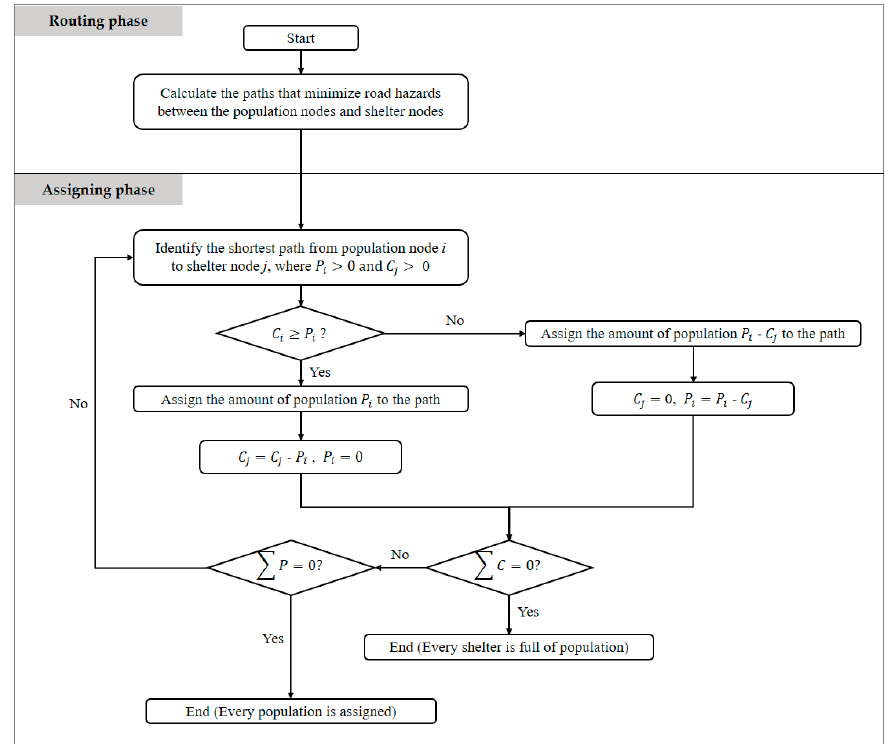
Figure 4. Process of comprehensive evacuation route analysis.